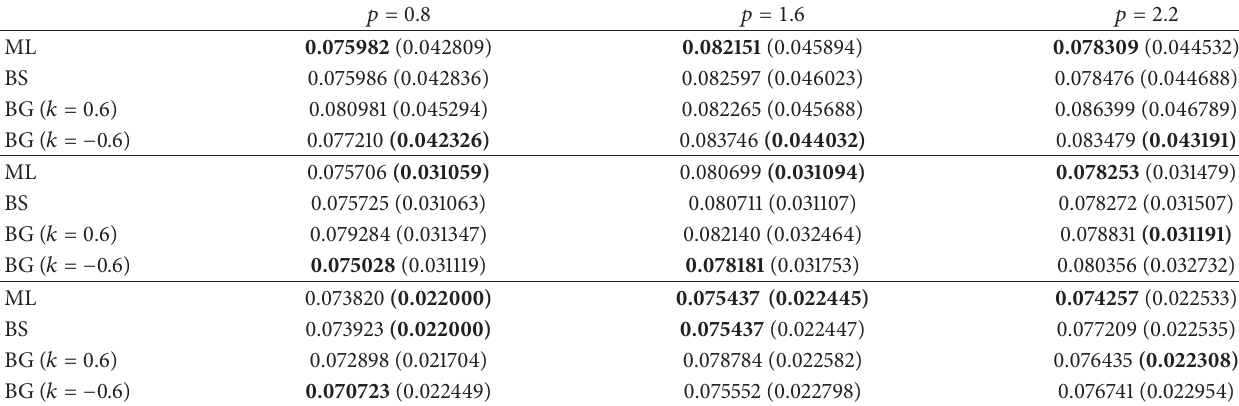
̂𝑆(𝑡) at 𝑇 = 25, 50 , and 100.